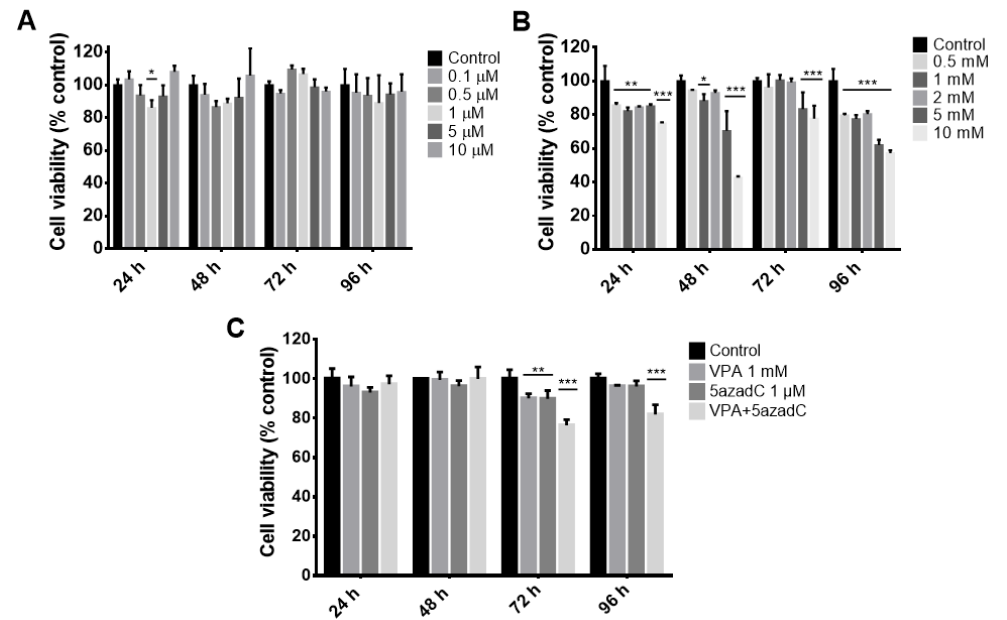
Figure 1. Cytotoxicity assays of epigenetic drugs 5-aza-2 ′ -deoxycytidine and valproic acid in hu- man dermal fibroblast cells. Dose–response–time analysis was performed to evaluate the cytotoxic effect of the epigenetic molecules 5AZ ( A ), VPA ( B ), and the combination of both ( C ). Values are expressed as mean ± SD from three independent experiments. Two-way ANOVA with Dunnett multiple comparison tests was used for comparisons between control and other groups. *, p < 0.05; **, p < 0.01; ***, p < 0.001.